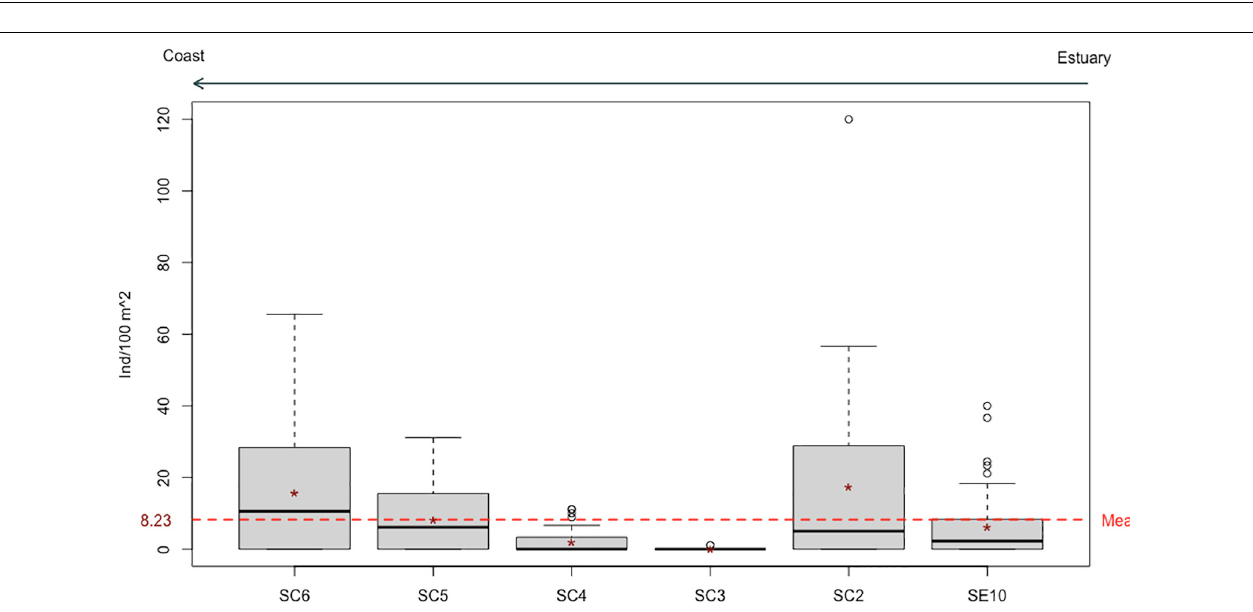
FIGURE 4 | Density of Holothuria mammata by sampling site, arranged according to distance to estuary (left to right). Red dotted line represents the overall mean value. * represents the mean of each sampling station.